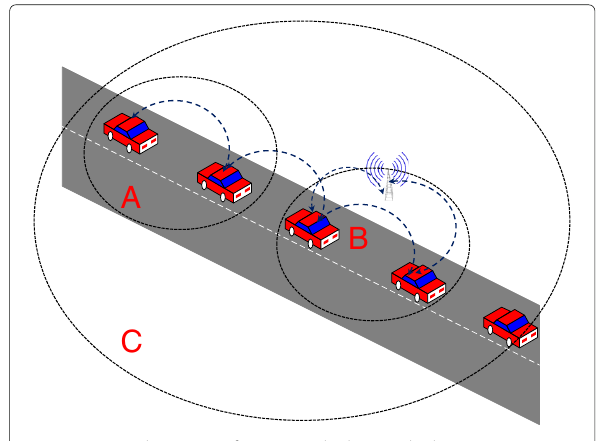
Fig. 1 Basic architecture of VSNs, a vehicle-to-vehicle (V2V), b vehicle-to-infrastructure (V2I), c